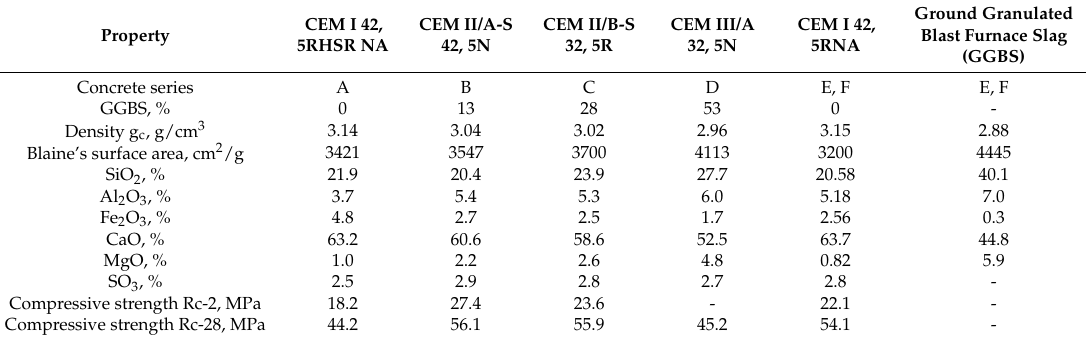
Table 1. Basic physico-chemical properties of the cement and GGBS used in the tests. Property Concrete